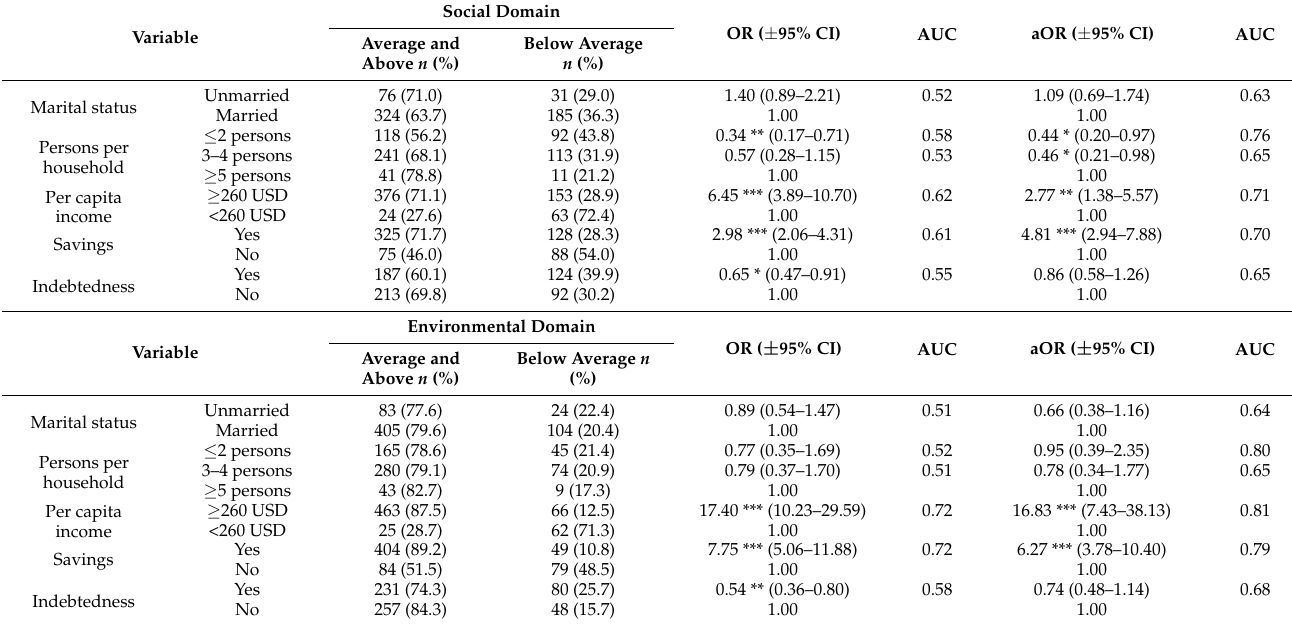
Table 6. Health-related quality of life in the social and environmental domains and socioeconomic status of private entrepreneurs from Wrocław ( N =